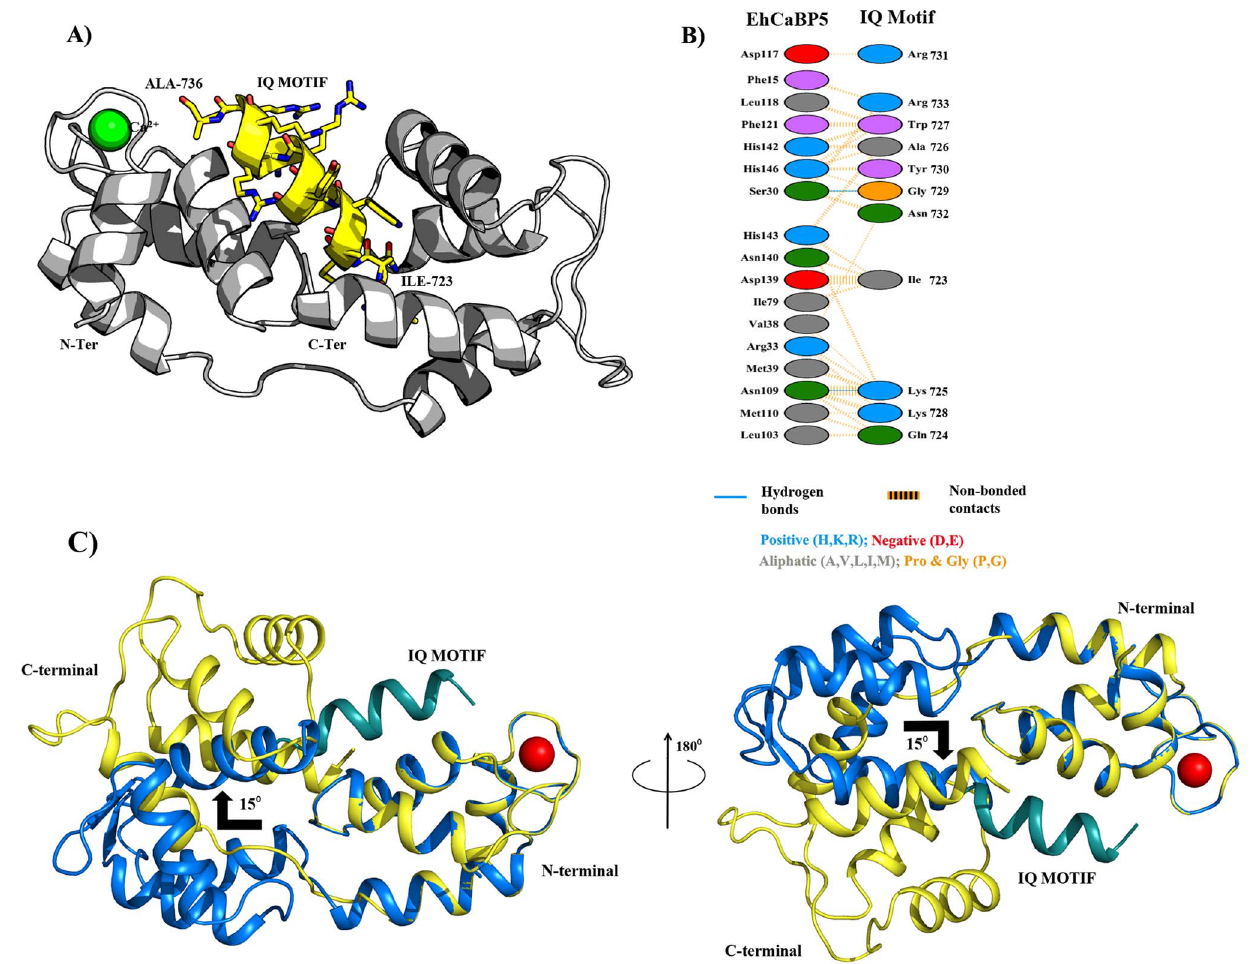
Fig 10. Protein-peptide Interaction. A) Rosetta-docked lowest energy model of EhCaBP5 (grey ribbon) bound with an IQ motif (yellow ribbon for backbone and sticks for side chains). B) Schematic representation of the contacts between EhCaBP5 and the peptide. The interaction shown by dotted orange lines are the non-bonded interactions, in which the width of the striped line is proportional to the number of atomic contacts. A blue line between any two residues indicates hydrogen bond interactions. C) Superimposition of the native EhCaBP5 crystal structure on the model of peptide-bound EhCaBP5 shows a predicted 15 u rotation of the C-lobe relative the N-lobe upon binding of the peptide.